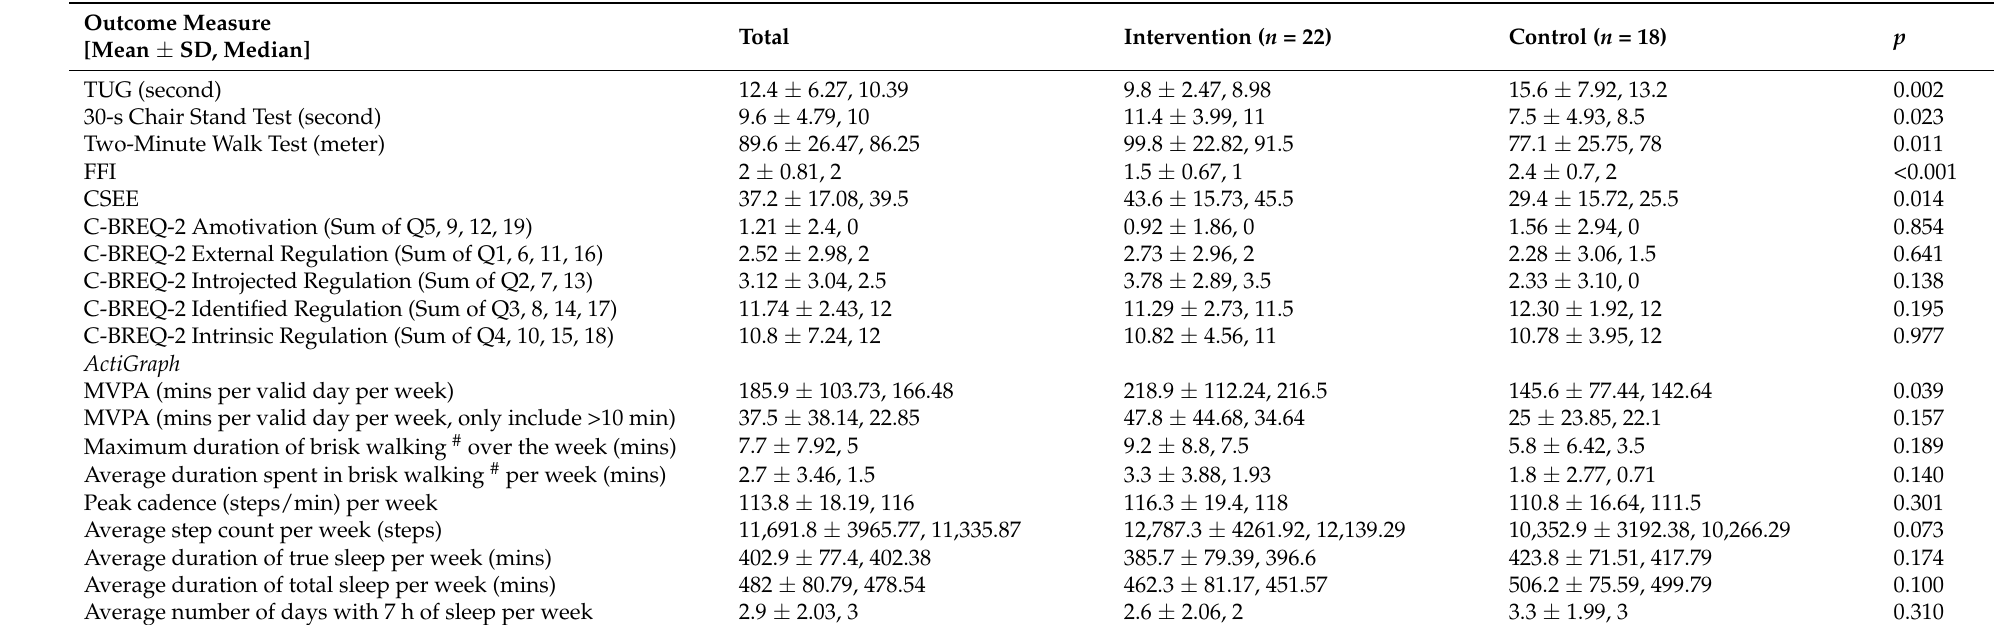
Table 2. Outcome measures at